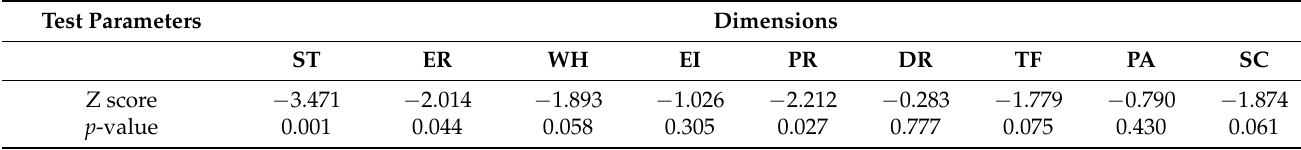
Table 3. Wilcoxon signed-rank test per paired APSQ-III dimensions (pre vs. post).